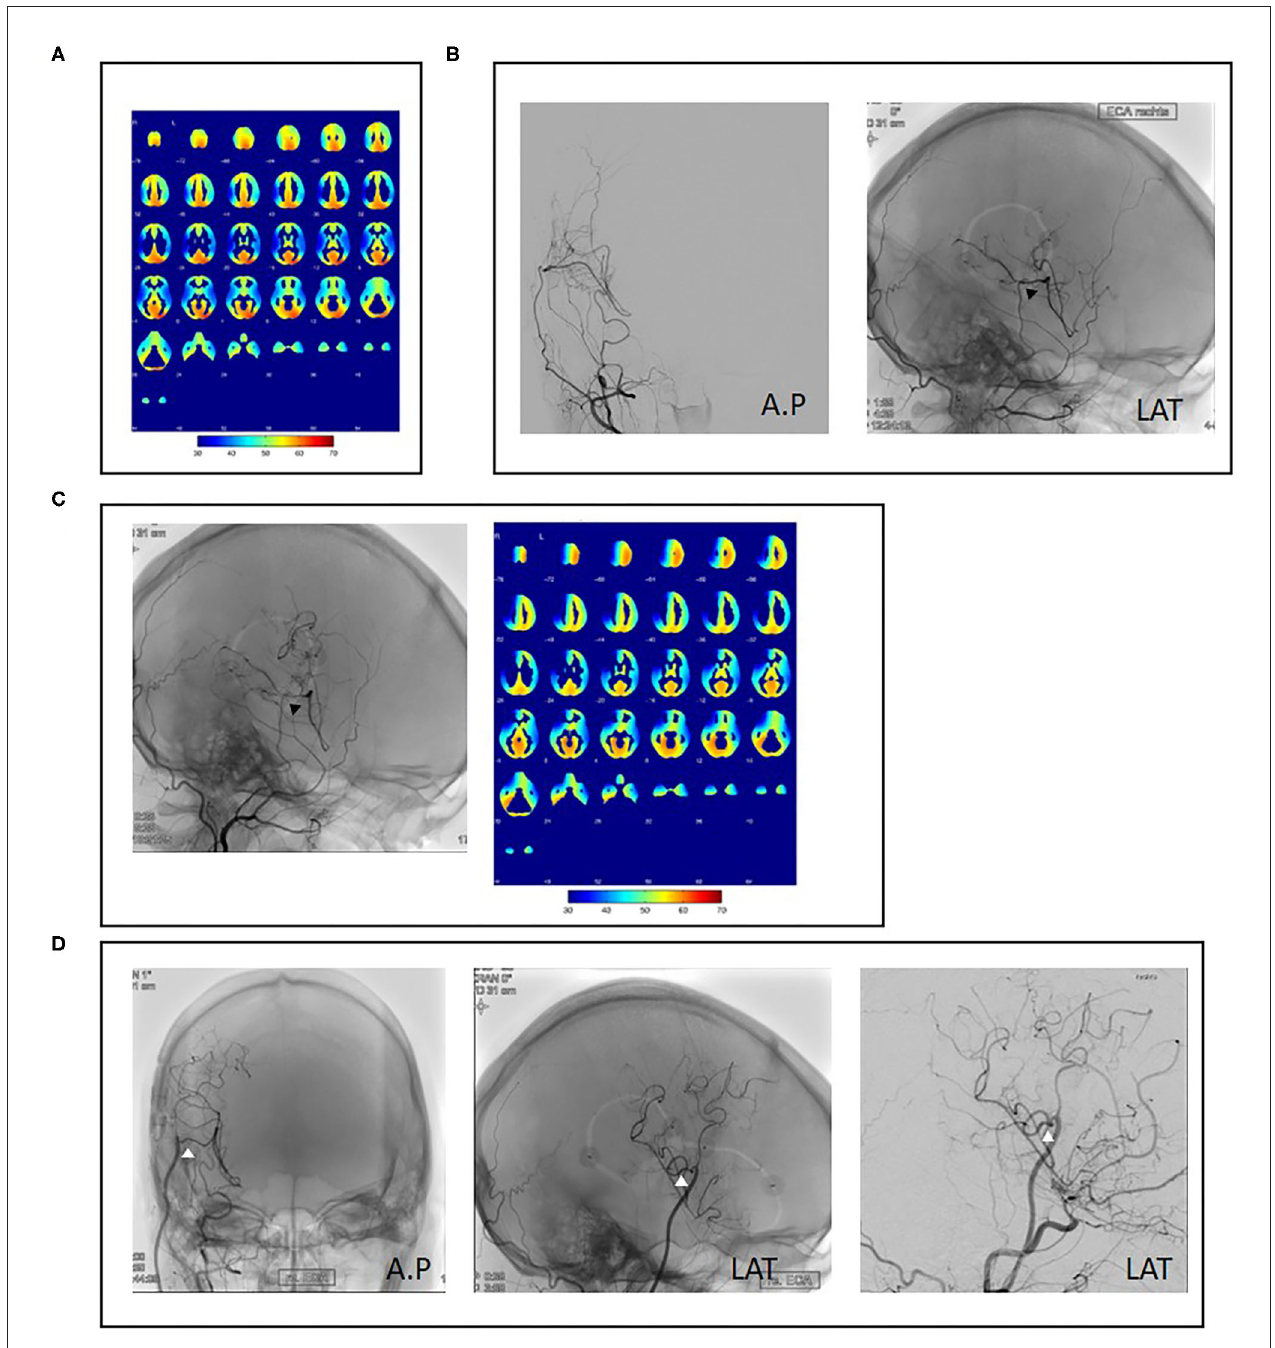
FIGURE 1 | Case example of repeat revascularization using a radial artery graft. A 34-year-old female patient presented with right hemispheric transient ischemic attacks (TIAs) and angiographic evidence of unilateral right-sided moyamoya disease as well as decreased cerebrovascular reserve capacity (CVRC) of the right hemisphere (A) . Revascularization using superficial temporal artery to middle cerebral artery (STA-MCA) plus encephalodurosynangiosis (EDS) was performed without complication ( B , black arrowheads). Fourteen months after initial surgery, the patient reported new left-sided hemihypesthesia. Angiography showed decreased bypass patency and decreased CVRC of the anterior MCA territory ( C , black arrowheads). As no frontal STA branch was available, repeat revascularization was performed with a radial artery graft ( D , white arrowheads).